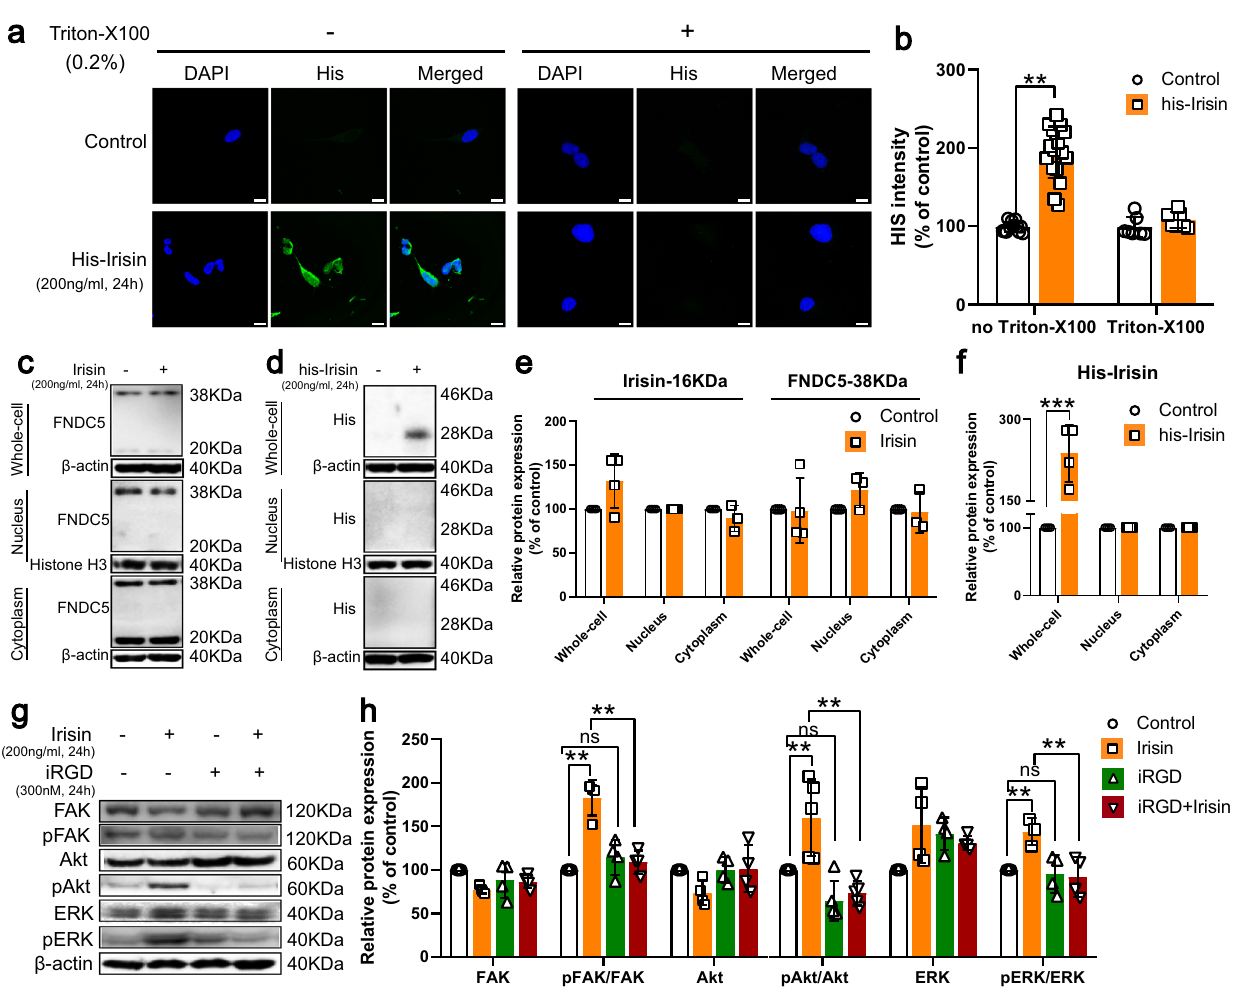
Fig. 7 Irisin confers neuroprotection by binding to α V integrin receptors to activate signaling pathways rather than directly targeting mitochondria after transported into the cell. a , b Confocal image and relative quantitative analysis of cell coverslips showing his- fl ag expression in irisin-treated SH-SY5Y cell. Scale bar, 100 μ m. c – f The SH-SY5Y cells were treated with irisin, his-irisin or control for 24 h. The cell lysates were analyzed by western blotting with the indicated antibodies. Data shows the quanti fi cation of irisin ( c , e ) or exogenous irisin ( d , f ) in whole-cell, cytoplasm and nucleus. g , h The SH-SY5Y cells were treated with irisin, iRGD peptides, or irisin and iRGD peptides for 24 h. The cell lysates were analyzed by western blotting with the indicated antibodies. Data shows the quanti fi cation of the p-FAK/FAK ratio, p-Akt / Akt ratio, p-ERK/ERK ratio. All data are presented as mean ± SEM ( n ≥ 3). ns p > 0.05, ∗ p < 0.05, ∗∗ p < 0.01, and ∗∗∗ p <